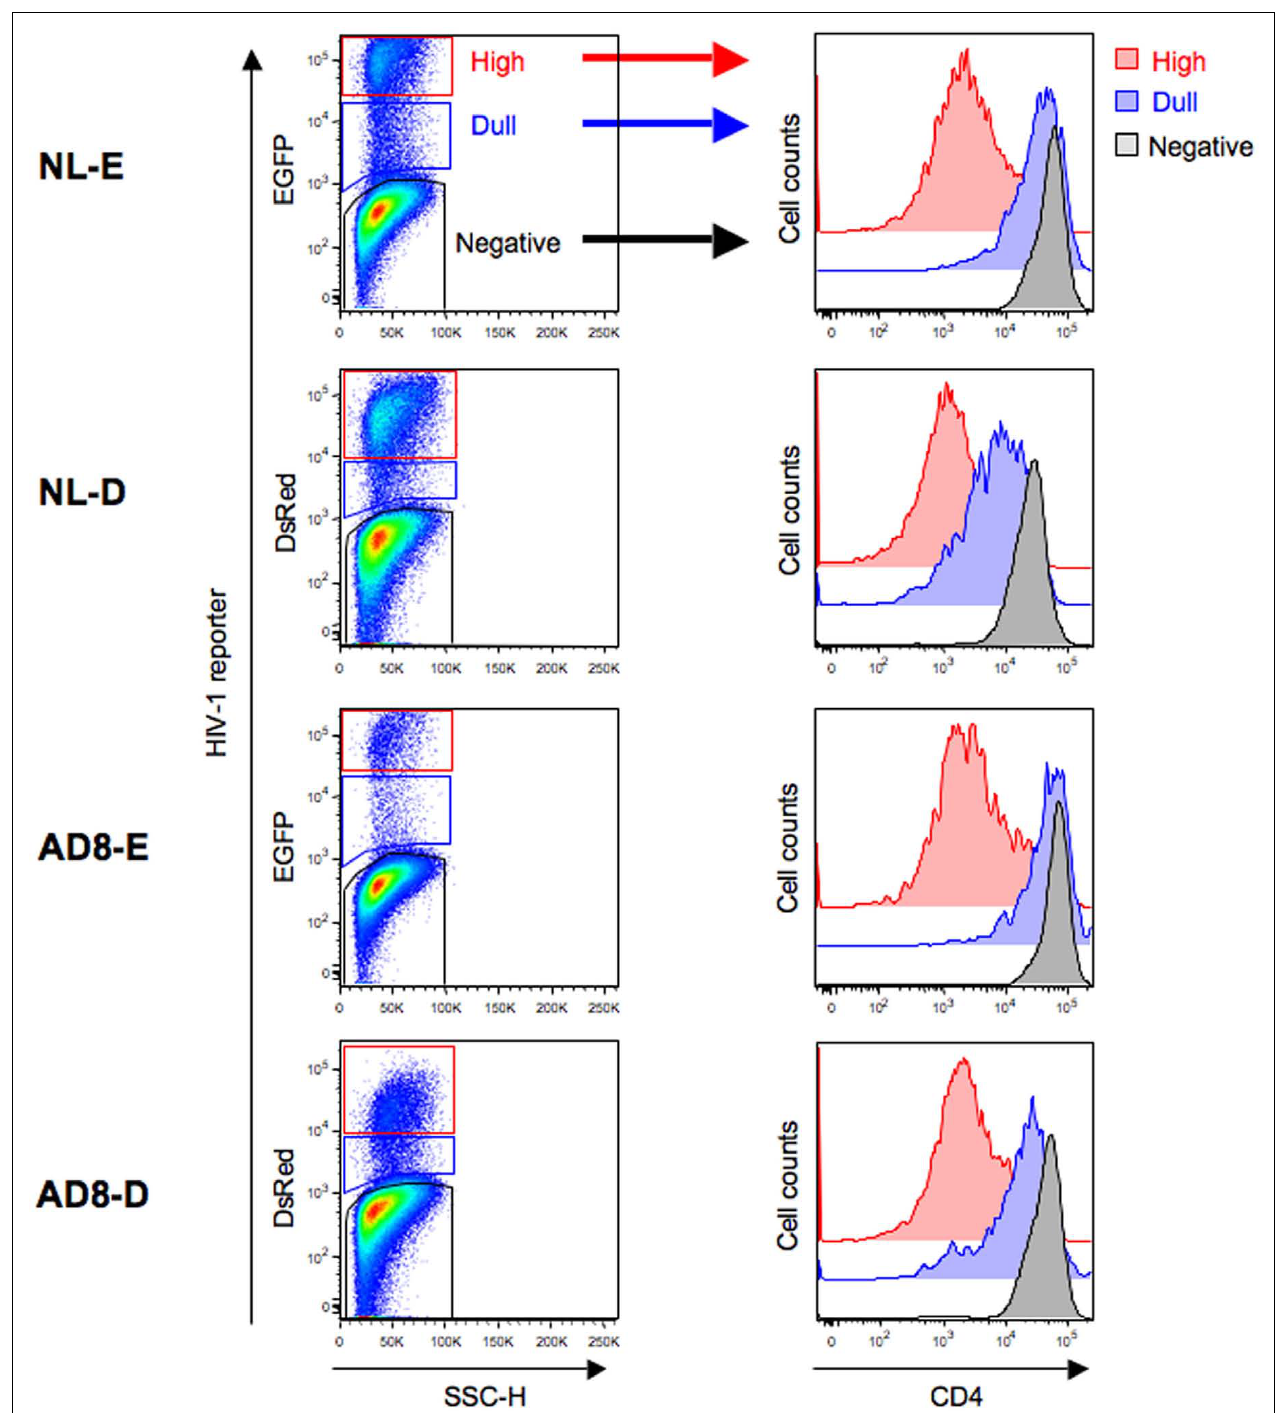
FIGURE 2 | Flow cytometry analysis of HIV-1-infected cells. Unstimulated CD4 + T cells were infected with HIV-1 NL-E , HIV-1 NL-D , HIV-1 NLAD8-E , or HIV-1 NLAD8-D and cultured for 5days (including the initial 1day culture with TCR-stimulation). (Left panels) representative pseudo-color plot profiles for